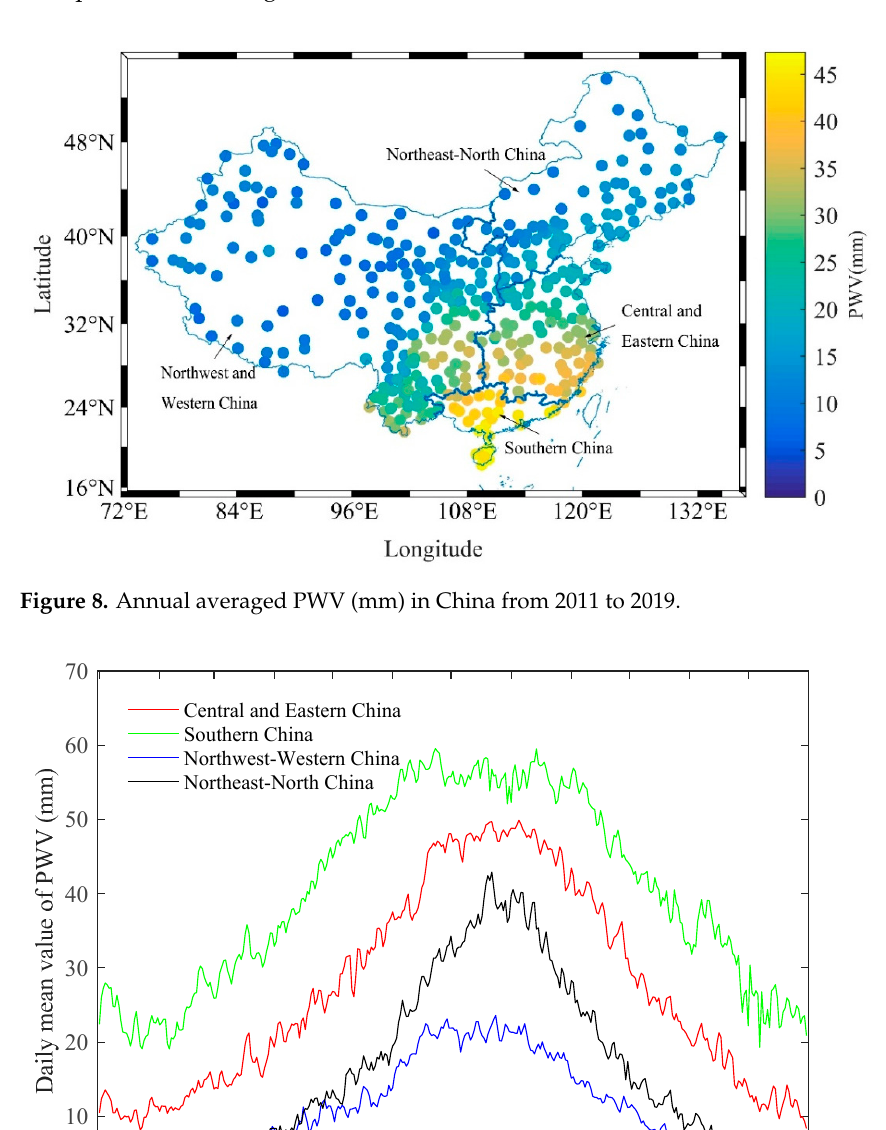
Figure 10. Annual PWV variation amplitudes (mm) at 377 GPS sites.